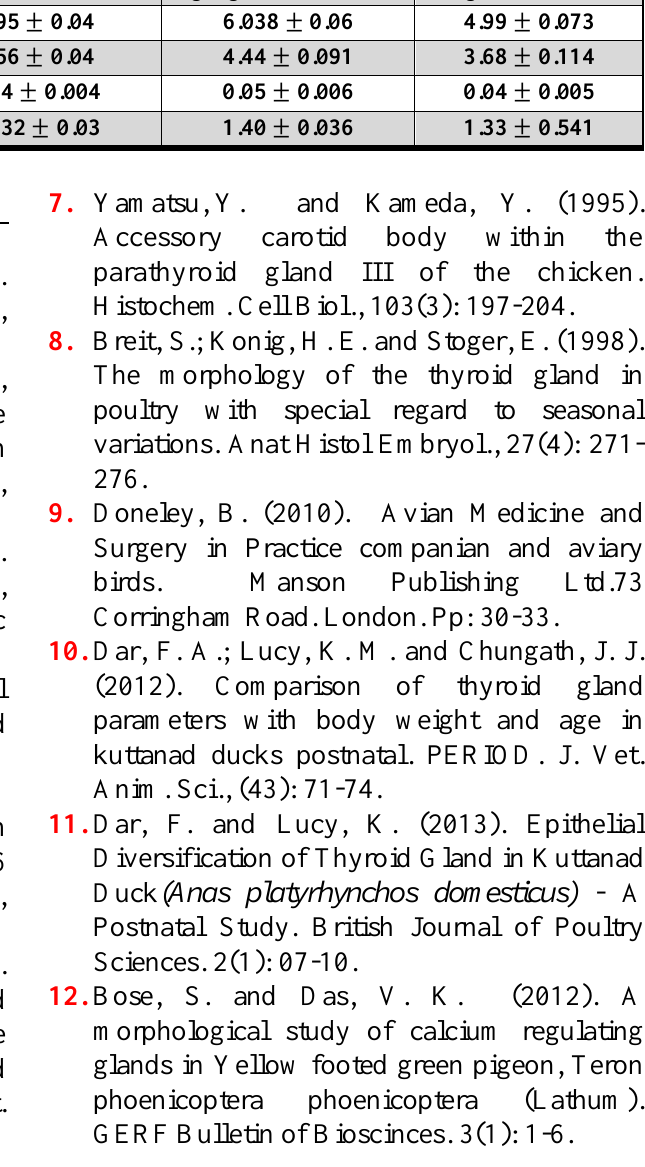
Left gland mean ± S.E Right gland mean ± S.E